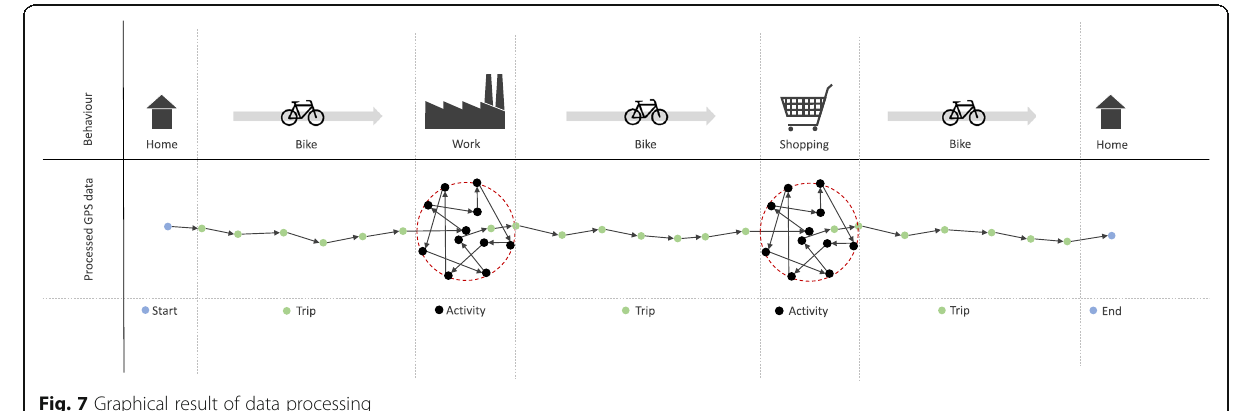
Fig. 7 Graphical result of data